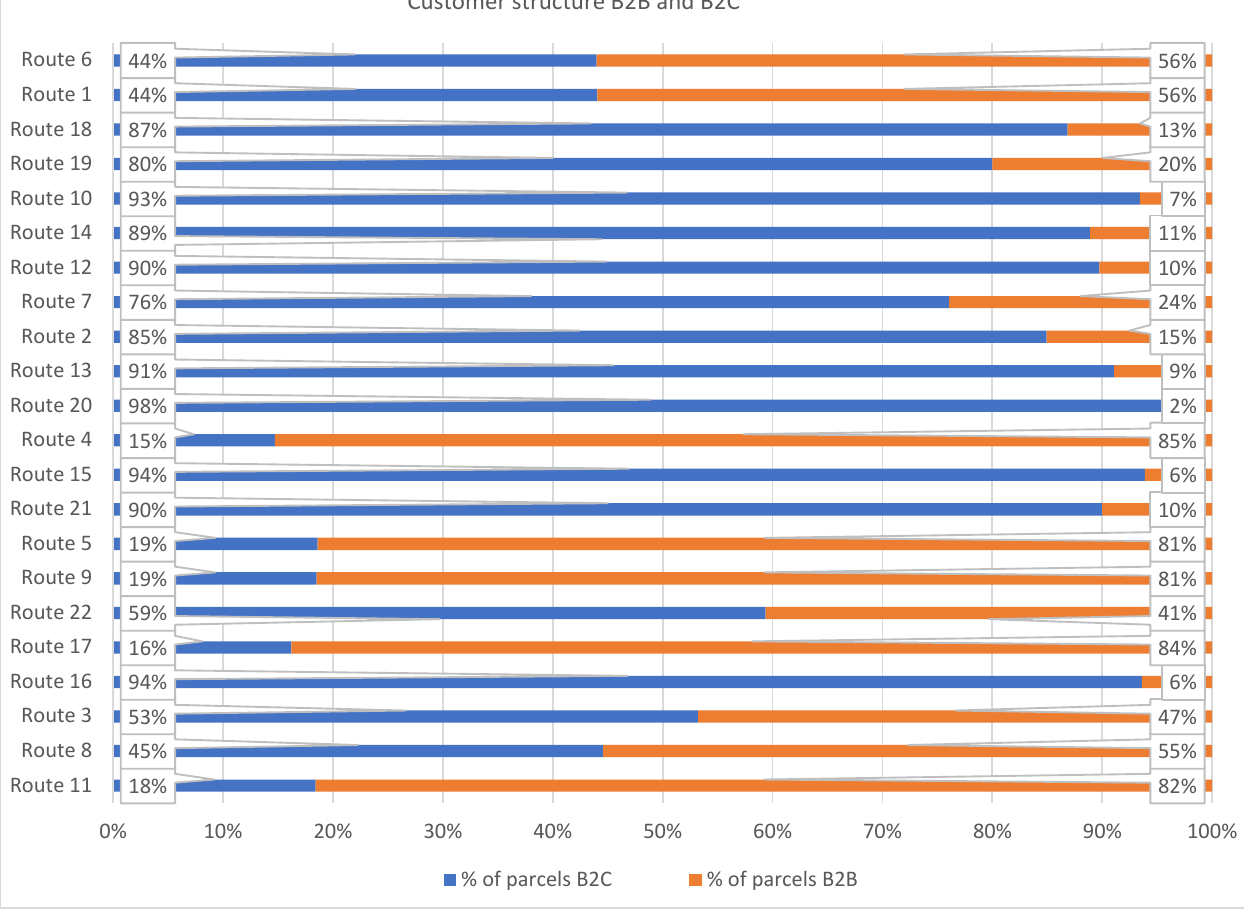
Figure 11. Structure of deliveries by B2B vs. B2C on the given route. Source: Own study.